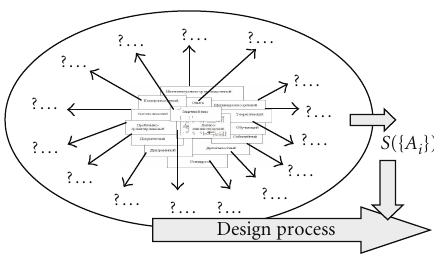
Figure 9: QA-model as a source of